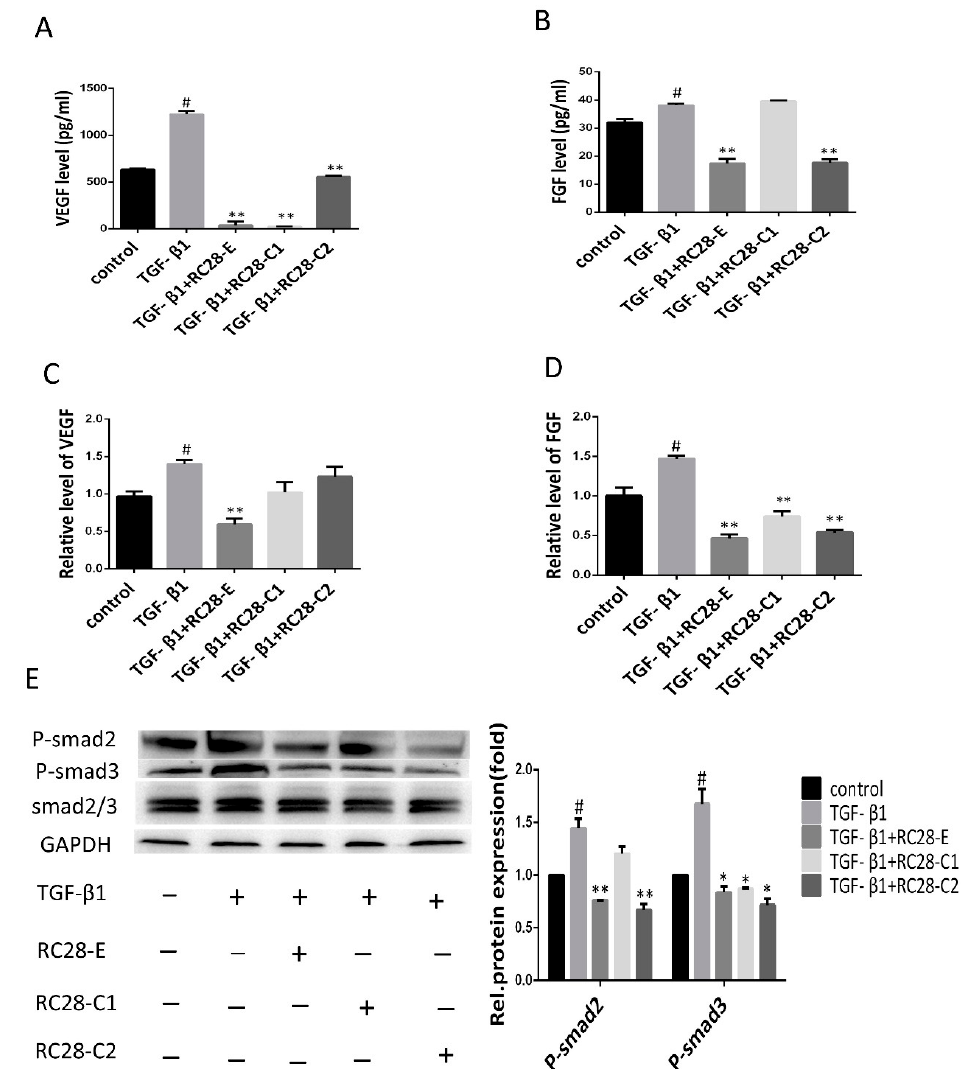
Figure 7. RC28-E downregulated protein levels of VEGF and FGF and inhibited the phosphorylation activity of the downstream signaling molecules Smad in human skin fibroblasts. ( A–E ) Human skin fibroblasts Detroit 551 were pretreated with RC28-E (2400 nM) for 1 h, followed by the addition of hTGF- β 1 into the culture medium to a final concentration of 10 ng/mL and incubation for 72 h. ( A , B ) The protein levels of VEGF and FGF were examined by ELISA. ( C , D ) The expression of VEGF and FGF mRNA were analyzed by qRT-PCR. ( E ) The expression of P-smad2, P-smad3, and smad2/3 was determined using western blot and GAPDH as loading control. Representative gel electrophoresis bands are shown, and the expression levels of proteins were quantified by densitometry and normalized to the expression of smad2/3. Densitometry data are shown as mean ± SD. * p < 0.05, ** p < 0.01 versus hTGF- β 1 alone. # p < 0.05, ## p < 0.05 versus control (n = 3).